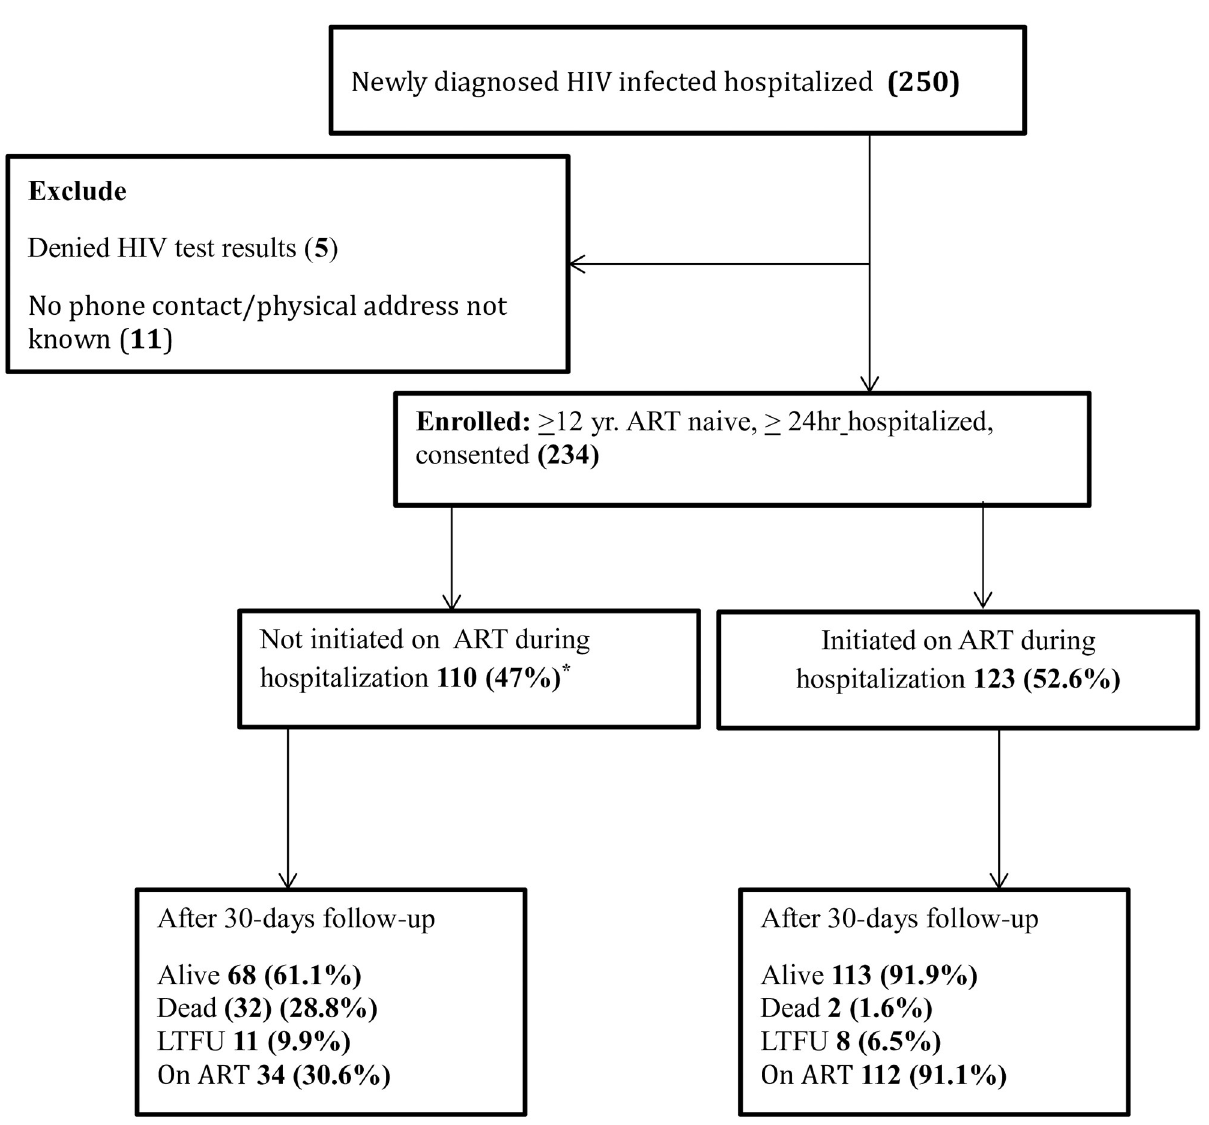
Fig 1. Study profile of hospitalized patients with a recent HIV diagnosis. � One patient was not assessed for ART status at discharge.